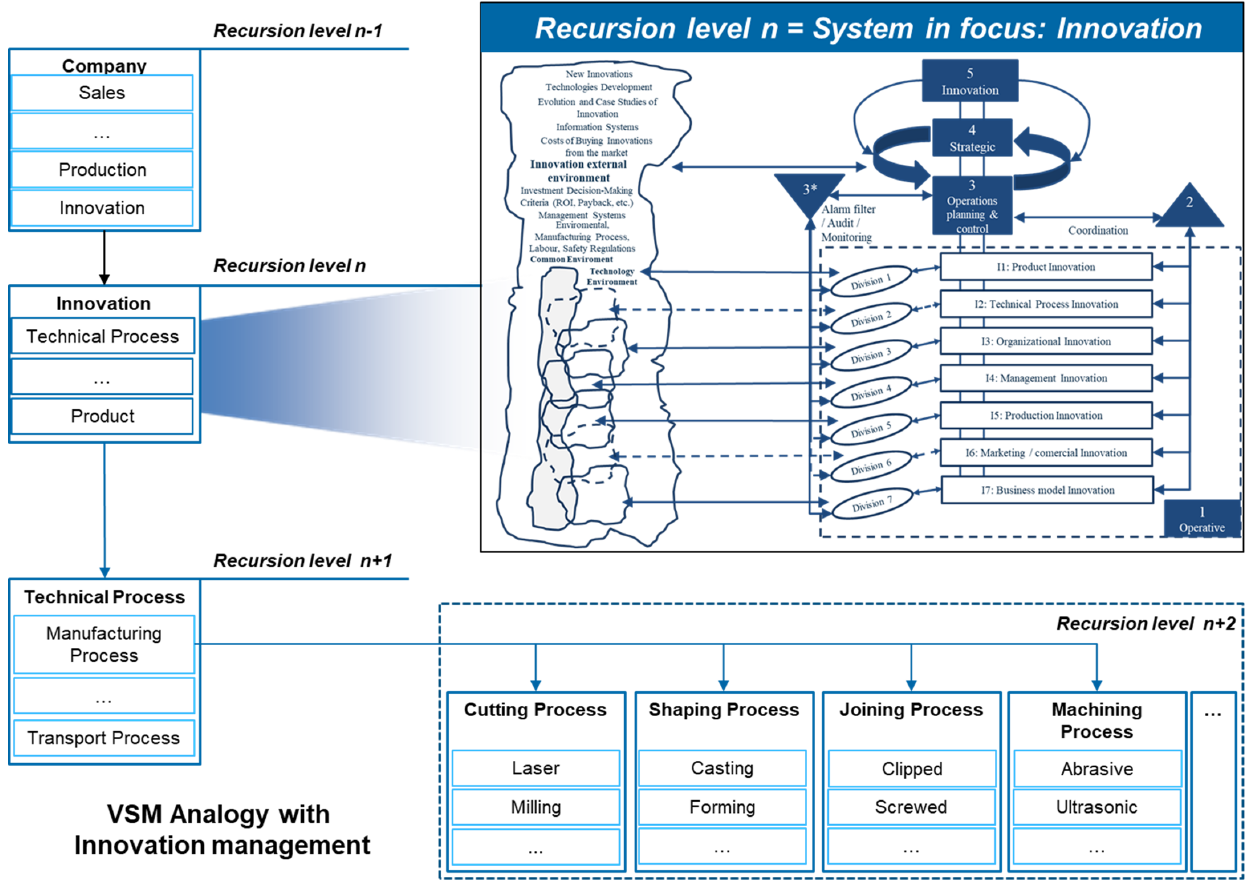
Figure 2. VSM recursion levels for company, innovation, technical process (own elaboration based on [44,45]).